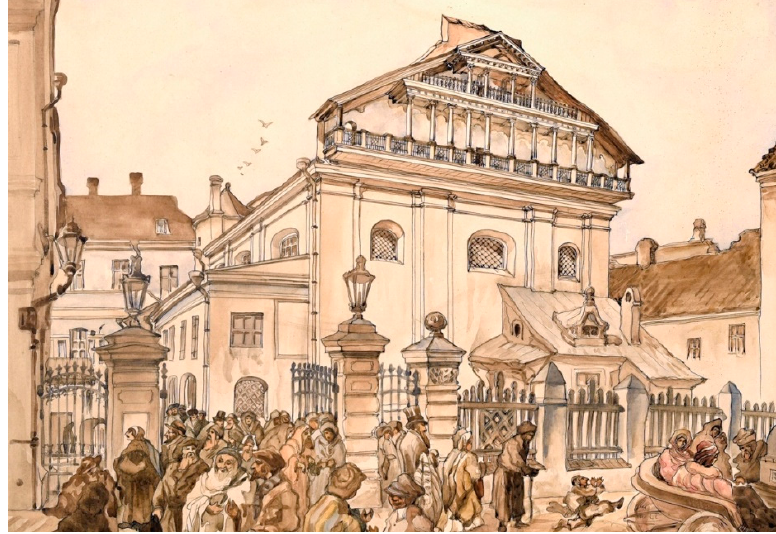
Figure 1. The Great Synagogue of Vilna in the 19th century—a drawing before the construction of the Strashun Library. Wikimedia Commons.